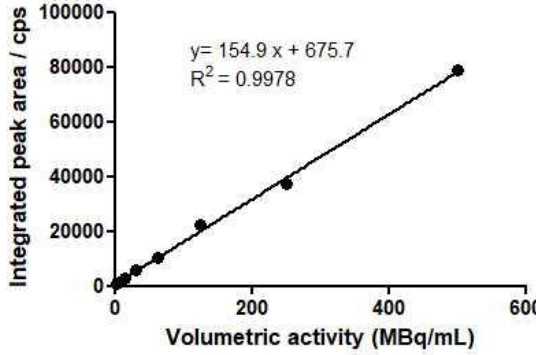
Figure 3. Linearity in HPLC method.